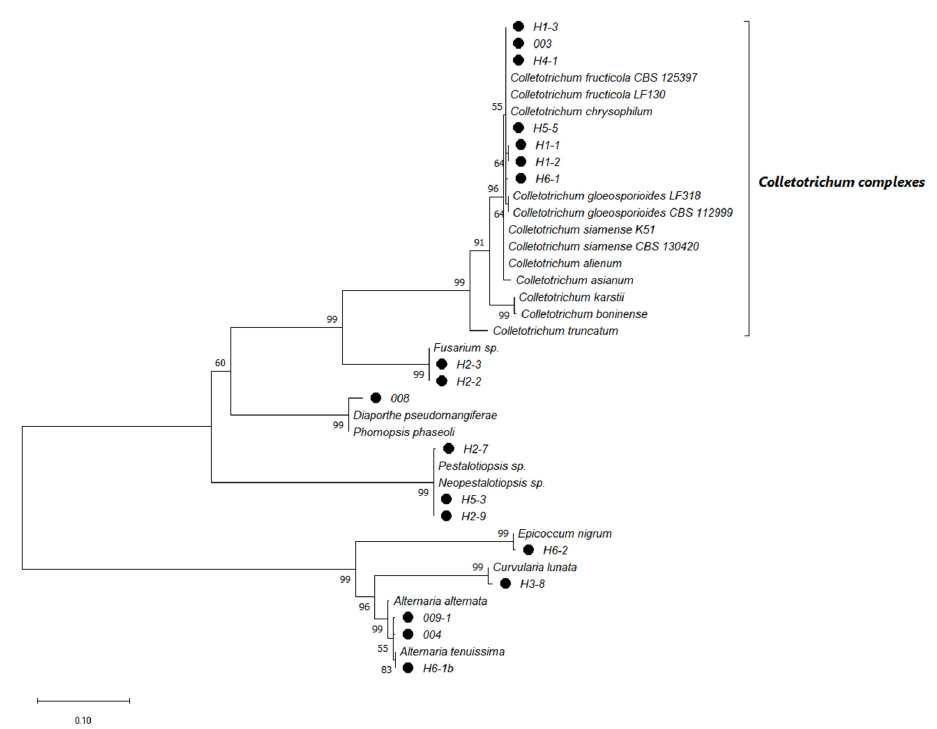
Figure 1. Tree phylogenetic relationship amongst fungi isolated from Mangifera indica L. with anthracnose-like symptoms. Maximum likelihood tree based on combined ITS and β -Tub 2 sequence data. Black dots show isolates characterized in the present work. Bootstrap support values are displayed at the tree nodes, and the branch lengths and scale bar represent the number of substitutions per site. ● Isolates from Guerrero, Mexico.